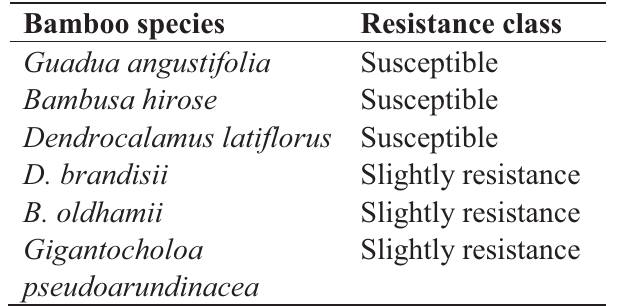
Table 4. Different resistance levels of bamboo